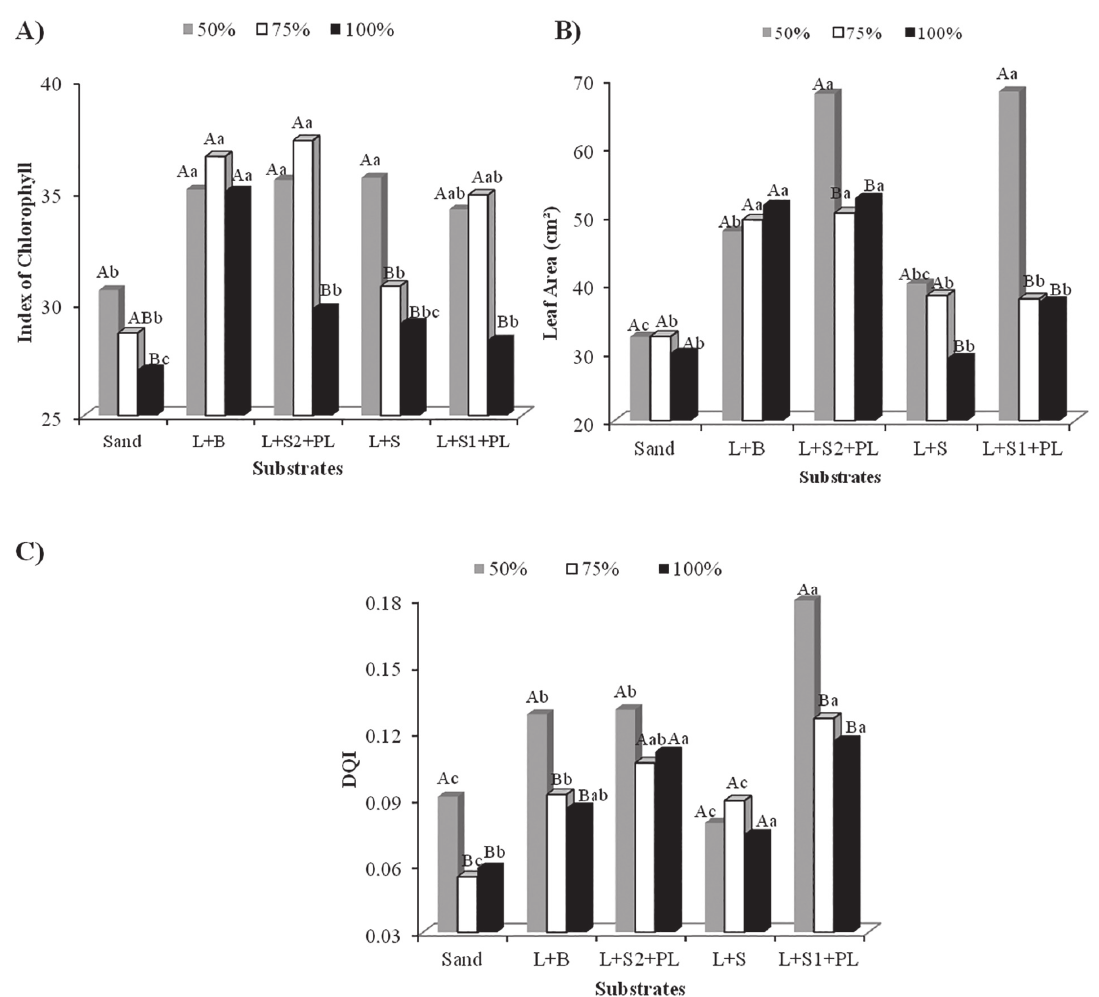
Figure 1 - Index of Chlorophyll (a), Leaf Area (b) and Dickson Quality Index (c) of uvaia seedlings (Eugenia pyriformis Cambess.), due to different substrates and water holding capacity (WHC). Means with the same capital letter do not differ signifi cantly from the levels of water retention capacity within the same substrate and lowercase for the level of water holding capacity between different substrates by Tukey test at 5% signifi